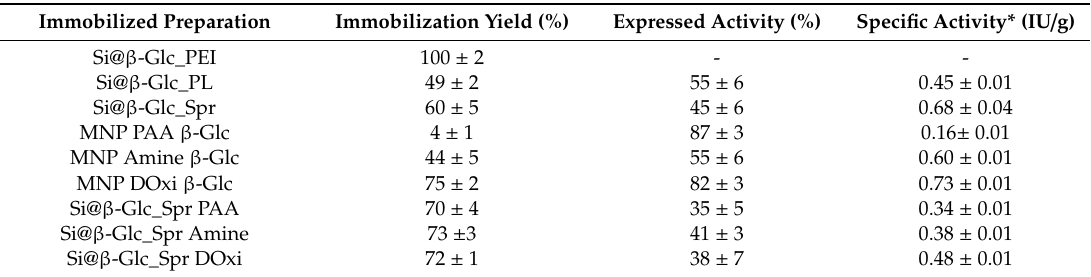
Table 1. Immobilization of β -Glucuronidase ( β -Glc) using di ff erent immobilization matrixes.